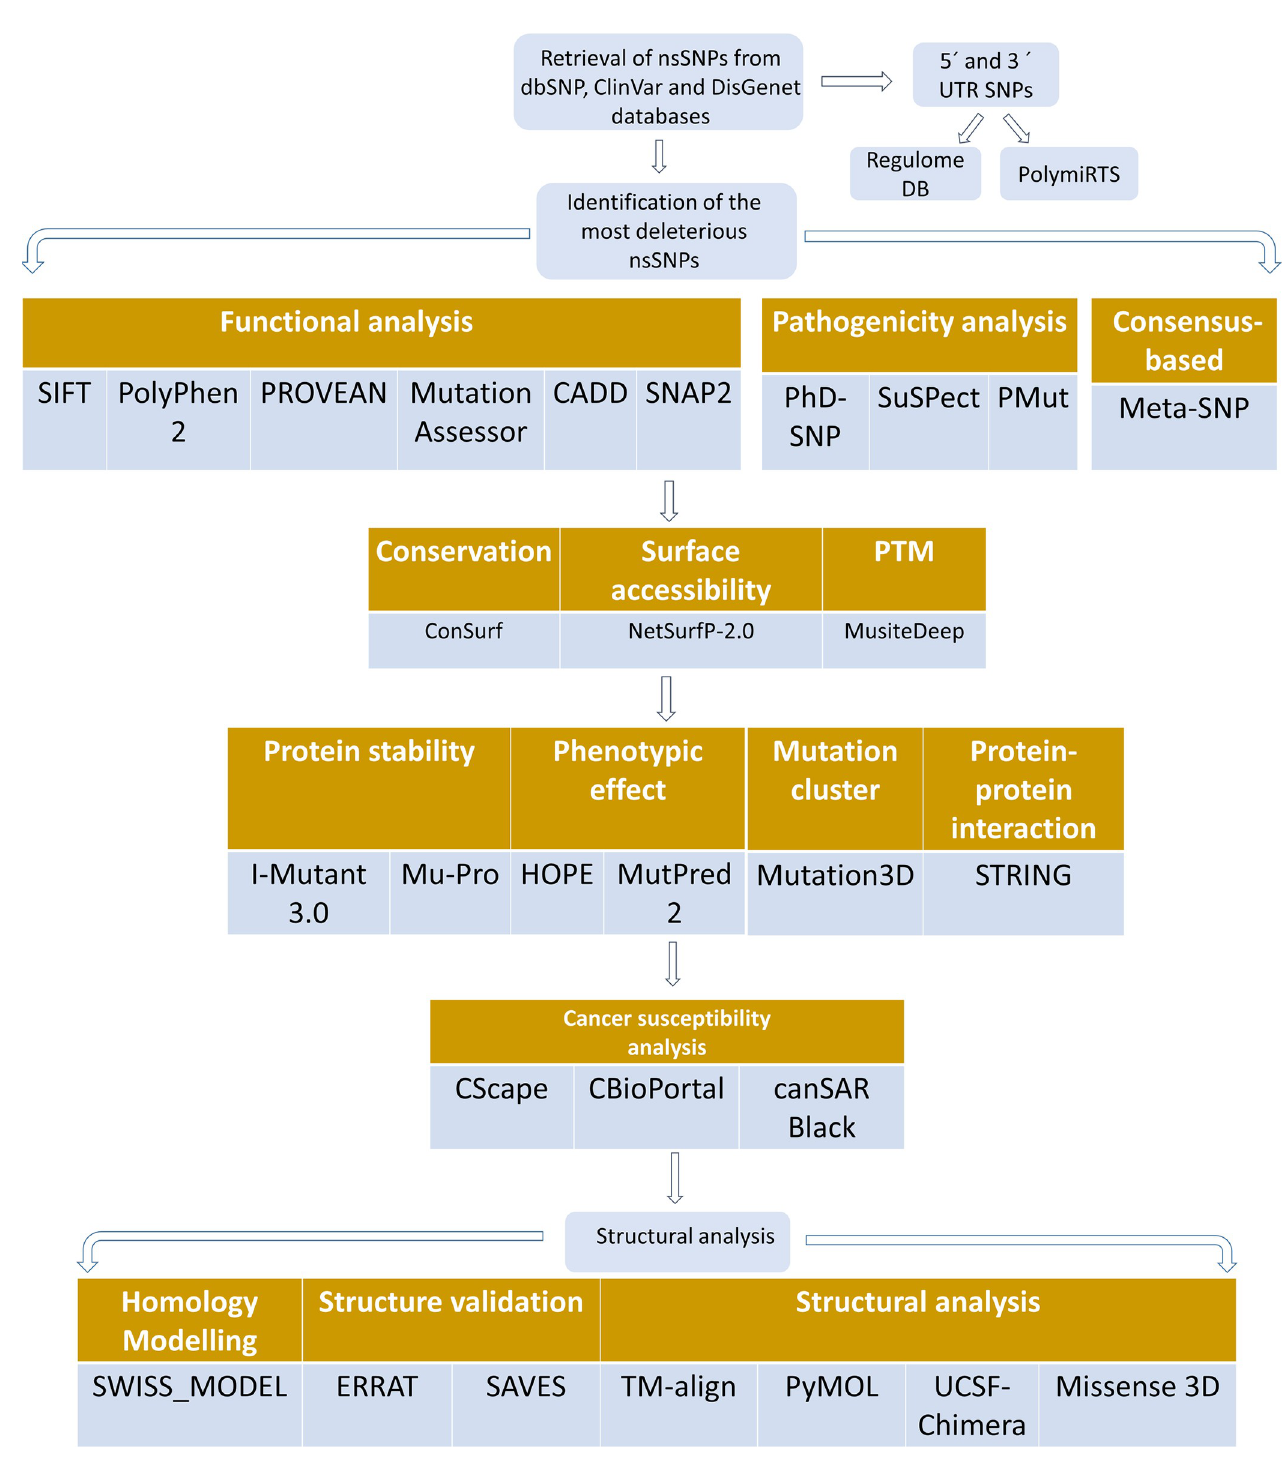
Fig 1. A flowchart depicting the entire study plan along with the tools that have been applied in the study.